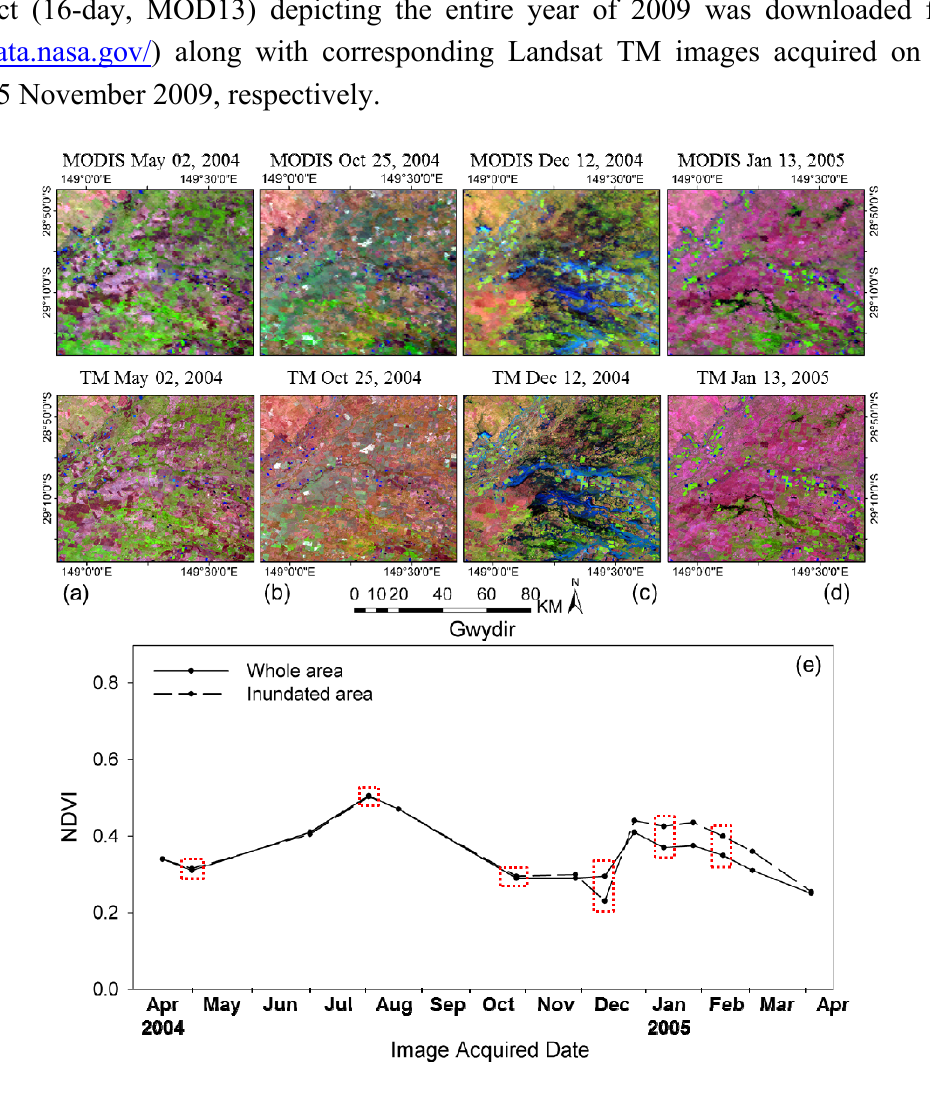
Figure 6. Sample pairs of Landsat-5 TM and MODIS data acquired at prediction dates ( a ) 2 May 2004, ( b ) 25 October 2004, ( c ) 12 December 2005, and ( d ) 13 January 2005 (SWIR-NIR-Red composite and identical linear stretch); and ( e ) the TM NDVI time-series of entire Gwydir and flooded area. All prediction dates are marked by red dotted